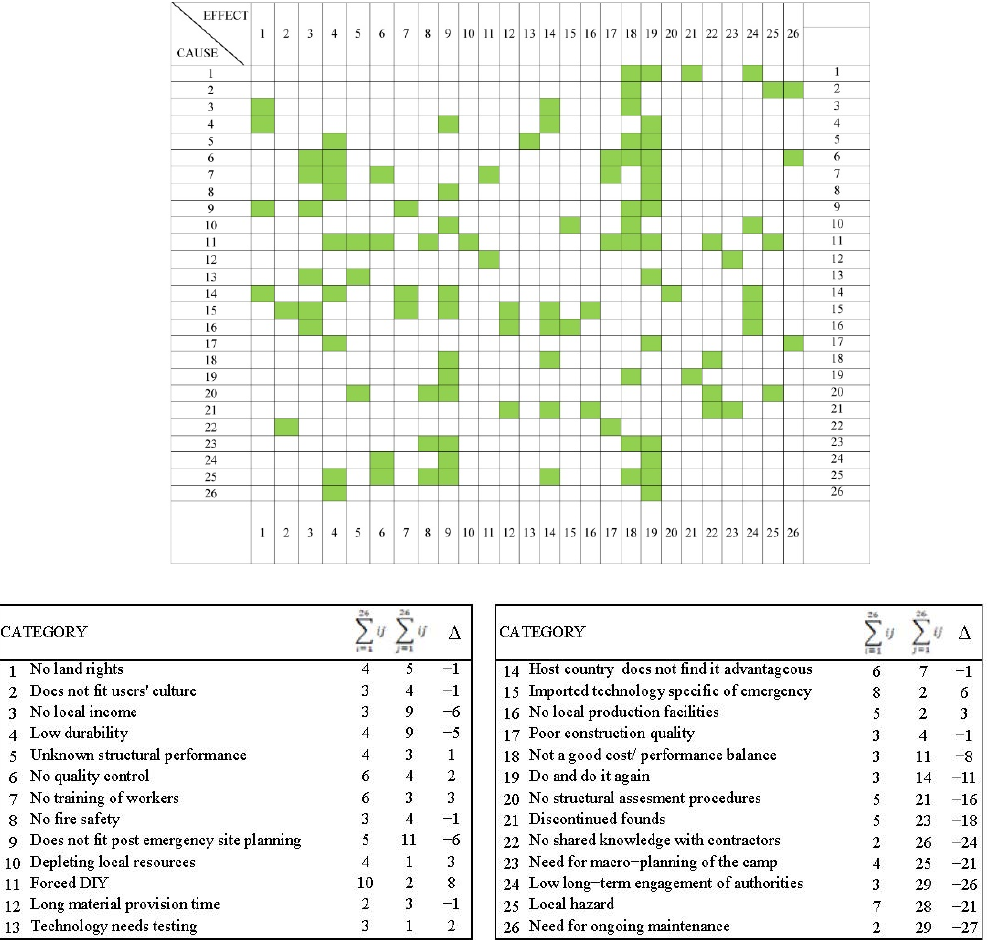
Figure 10. The interrelationship matrix (above) and the chart (below) of 26 identified categories. The numbers in the matrix identify the 26 categories described in the chart. The existence of a direct relationship between the categories is expressed by a coloured cell in the matrix and computed in the chart.